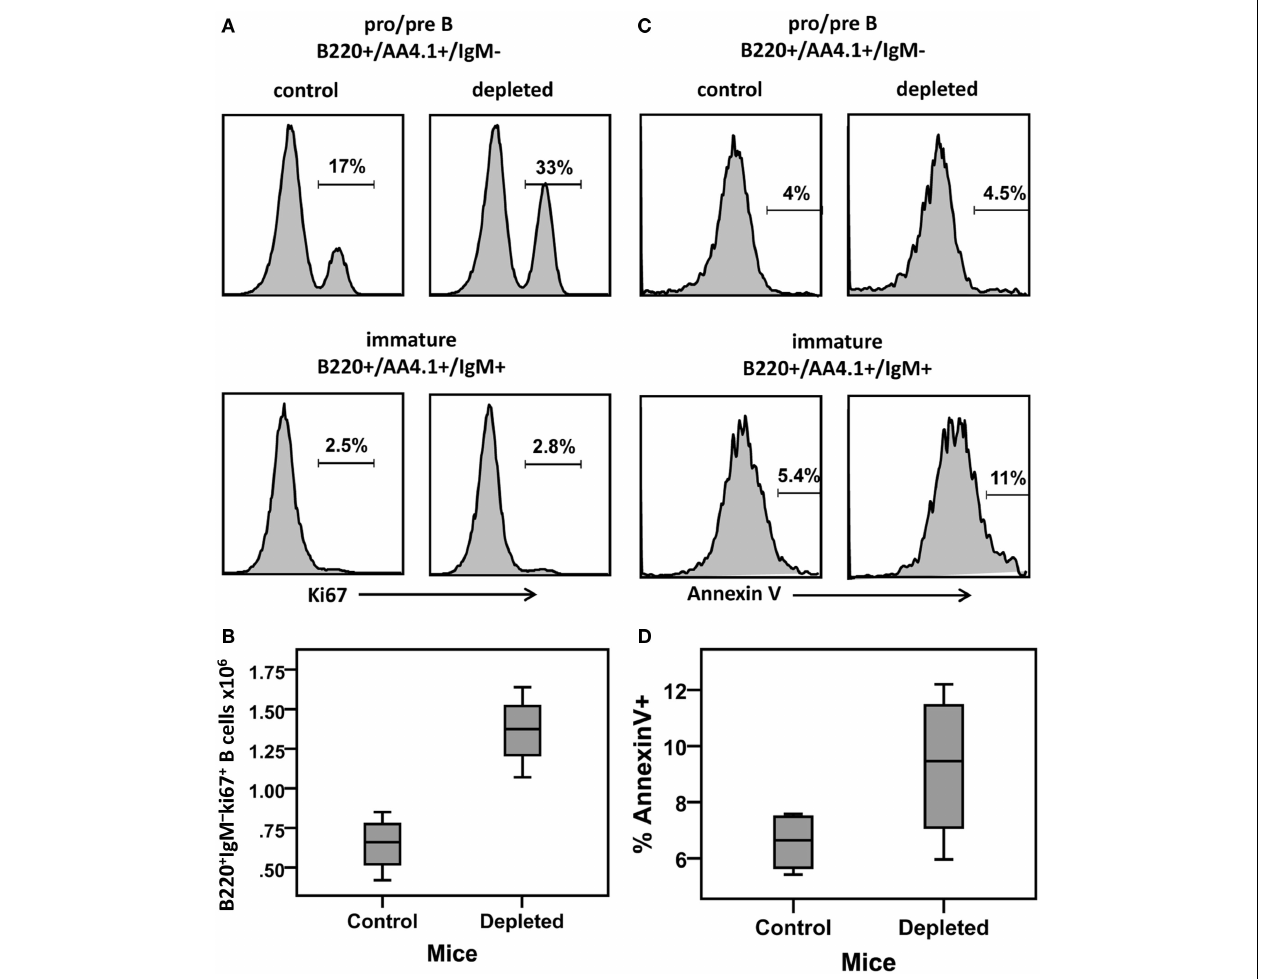
FIGURE 6 | BM cells from control and hCD20-depleted mice (34days after depletion) were stained for B220 IgM AA4.1 and Ki67 or Annexin V . For analysis, viable lymphocytes were defined by forward and side light scatter and the relative Ki67 or Annexin V staining in pro-/pre-B (B220 + /AA4.1 + /IgM (cid:0) ) or immature (B220 + /AA4.1 + /IgM + ) B cell subsets was determined using gates set as shown in Figure 2A . (A) Histograms showing Ki67 expression inthe gated pro-/pre- and immature B cell subsets in the control and depleted mice (representative example). (B) Ki67 + cell numbers in the pro-/pre-B cell compartment in control and B cell-depleted mice. (C) Histograms showing Annexin V expression in the pro-/pre-B and immature cell subsets in control and depleted mice (representative of four mice in each group). (D) Percentages of Annexin V + cells in the pro-/pre-B and immature B cell compartments in control and B cell-depleted